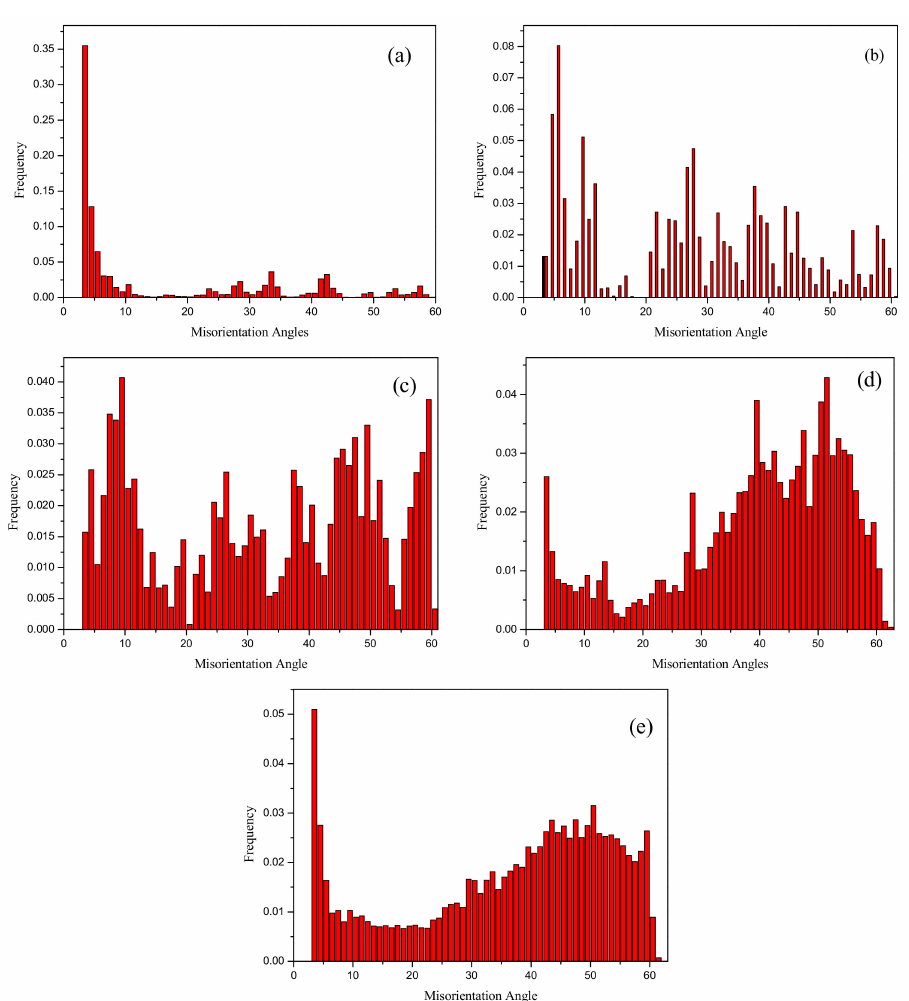
Figure 4. Distributions of misorientation angles of as-cast 7085 and TiC / 7085 ( a ) 7085; ( b ) 0.1 wt% TiC / 7085; ( c ) 0.3 wt% TiC / 7085; ( d ) 0.5 wt% TiC / 7085; ( e ) 1 wt% TiC /